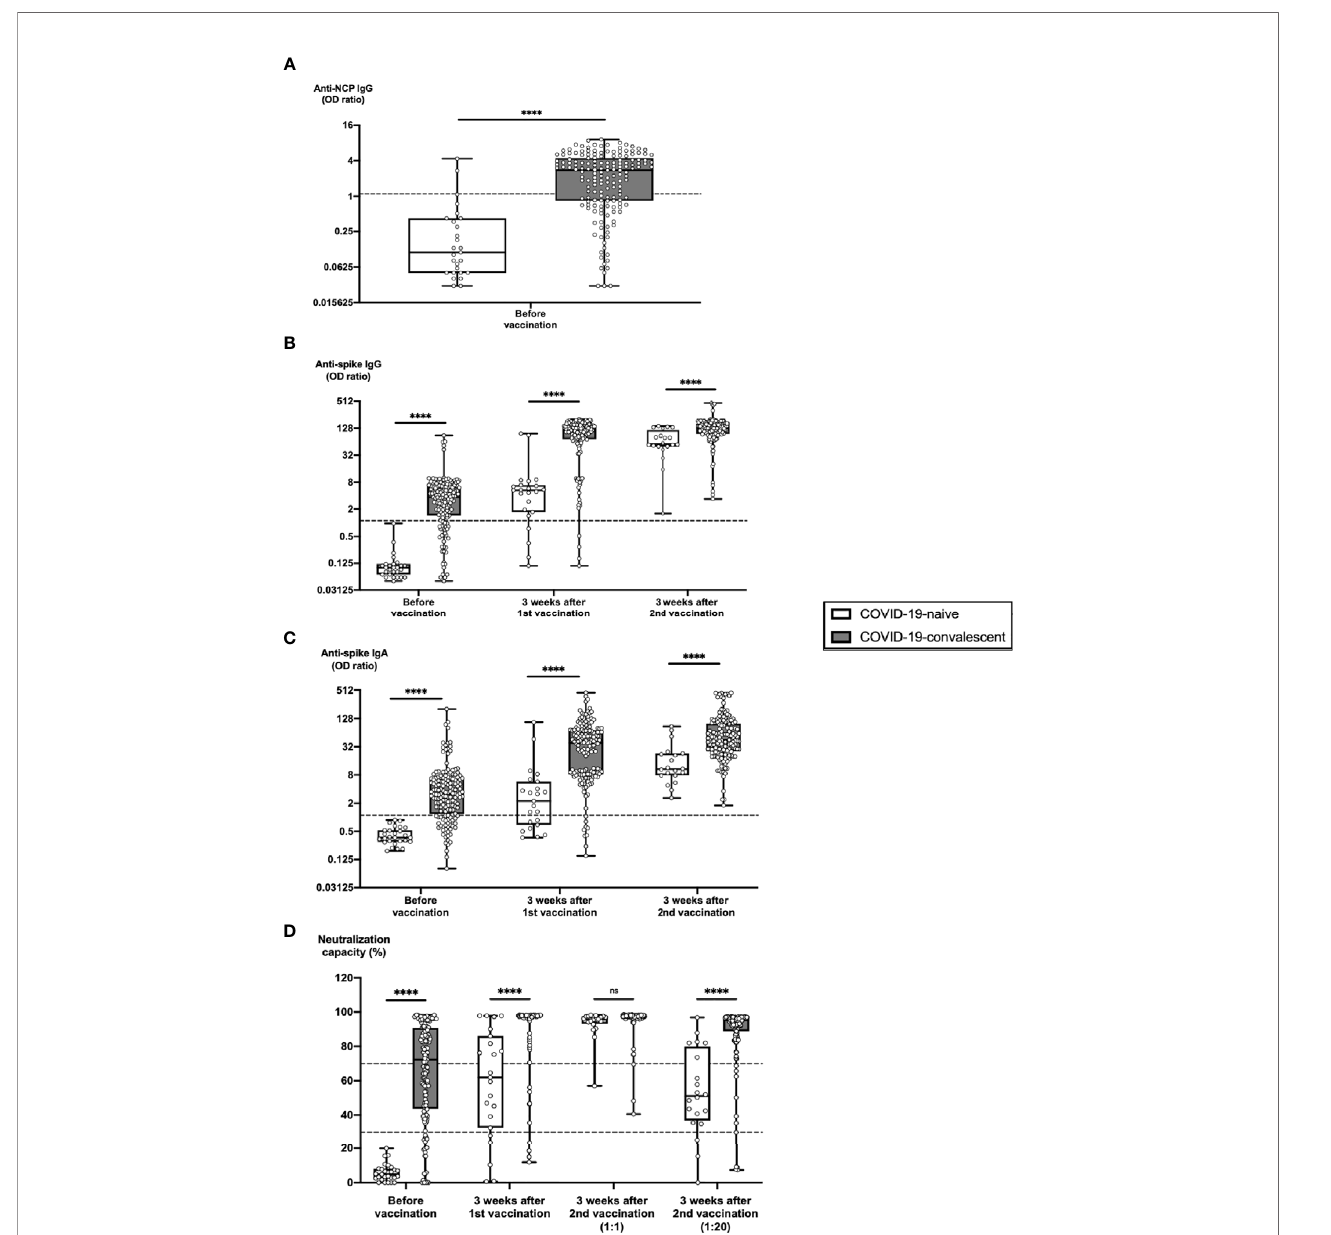
FIGURE 1 | Humoral SARS-CoV-2-speci fi c immune parameters after vaccination of COVID-19-naive versus -convalescent individuals. Serum samples from 163 subjects with con fi rmed COVID-19 history (COVID-19-convalescent, CC) and from 27 subjects without such history (COVID-19-naive, CN) were collected before vaccination, 3 weeks after fi rst vaccination and 3 weeks after second vaccination with BNT162b2. Samples were analyzed for anti-NCP IgG titers, anti-spike IgG and IgA titers as well as for ACE2-RBD neutralization capacities. Box blots show (A) anti-NCP IgG titers, (B) anti-spike IgG titers, (C) anti-spike IgA titers and (D) median neutralization capacities at different time points as indicated. Dotted lines indicate cutoff values. To further differentiate high neutralization capacities 3 weeks after second vaccination, an additional analysis using an extra serum pre-dilution of 1:20 was performed (blot pair on the right side in panel D). Box central horizontal lines indicate medians, box borders represent IQR, whiskers indicate minima and maxima. Signi fi cance level was ****p < 0.00005. ACE2, angiotensin-converting enzyme 2; IQR, interquartile ranges; NCP, nucleocapsid; ns, not signi fi cant; OD, optical density; RBD, receptor-binding